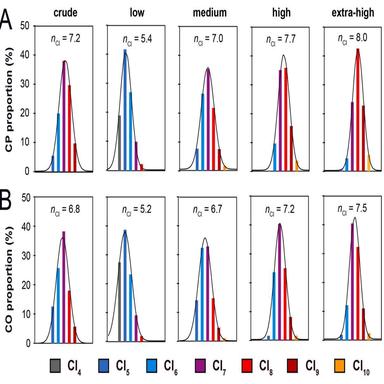
Homologue distributions of paraffinic (A) and olefinic (B) C18-materials. Non-interfered signal intensities (I100%) for different CP and CO homologues were obtained from mathematical deconvolution. From these data homologue distributions and chlorine numbers (nCl) were deduced. Respective distributions were also modeled as Gaussian functions.